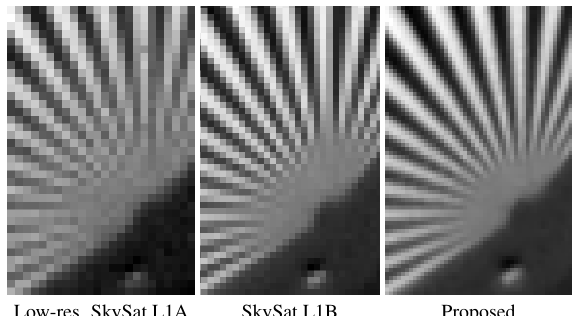
Figure 1. Examples of reconstruction on a real ground fan target from 35 low-resolution SkySat L1A frames. From left to right: reference low-resolution L1A frame, L1B product provided by Planet ( × 1 . 25 ), proposed method ( × 2